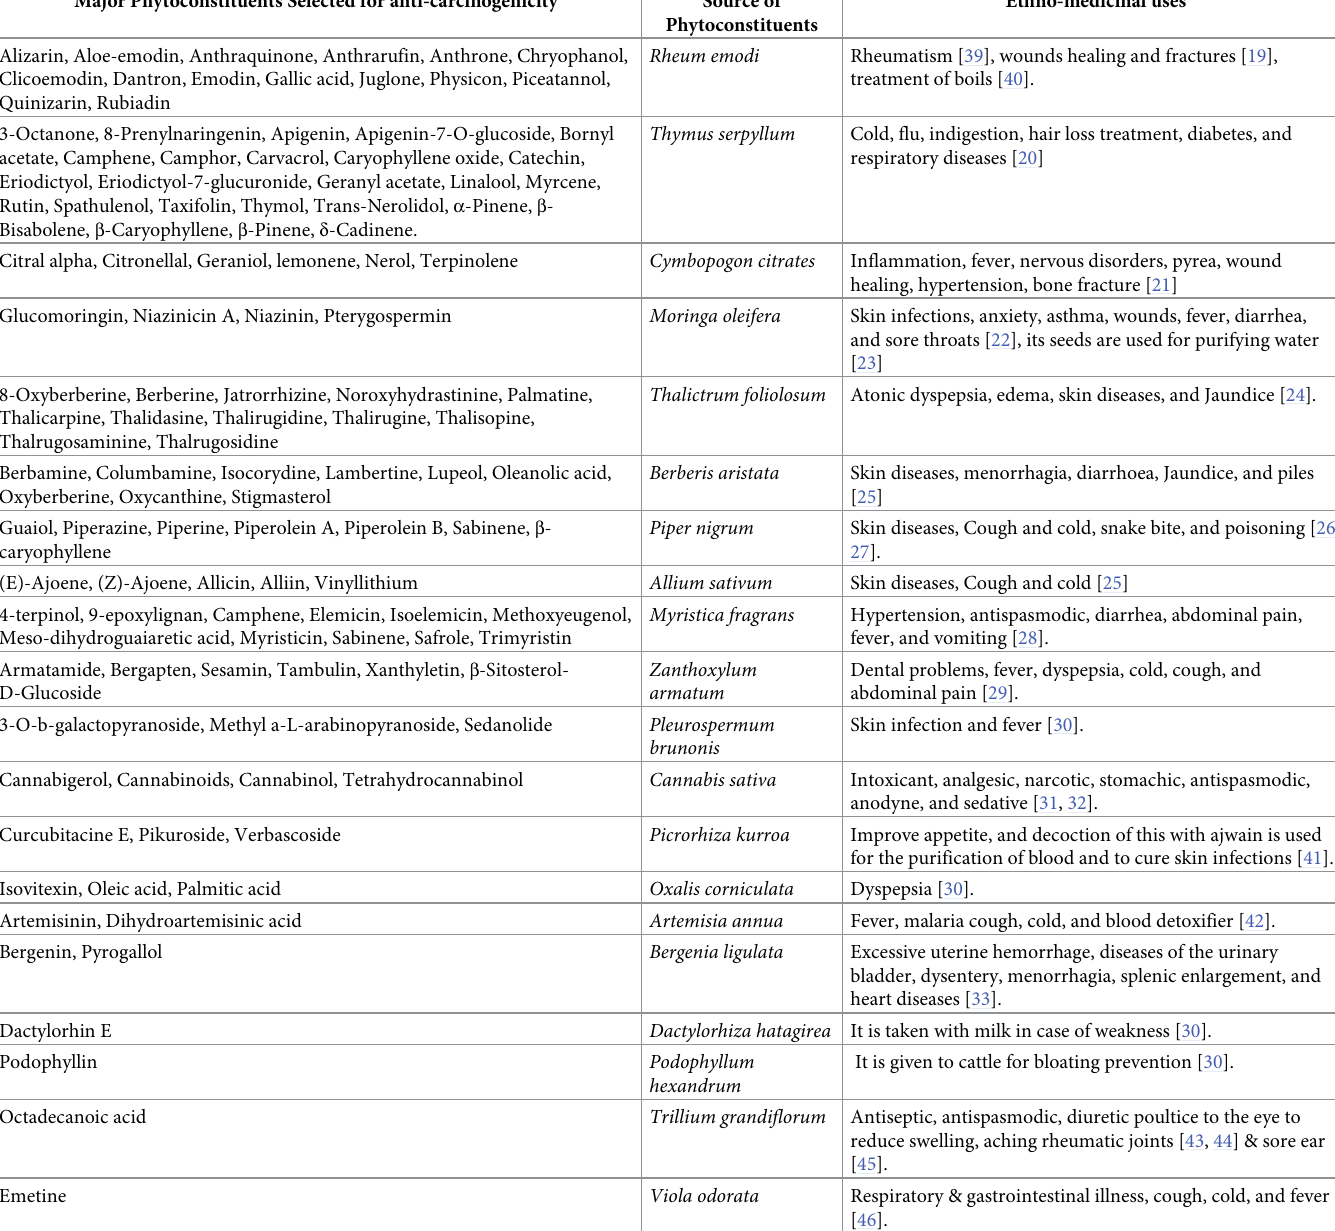
Table 1. Ethno-medicinal uses and plant sources of selected phytoconstituents. Major Phytoconstituents Selected for